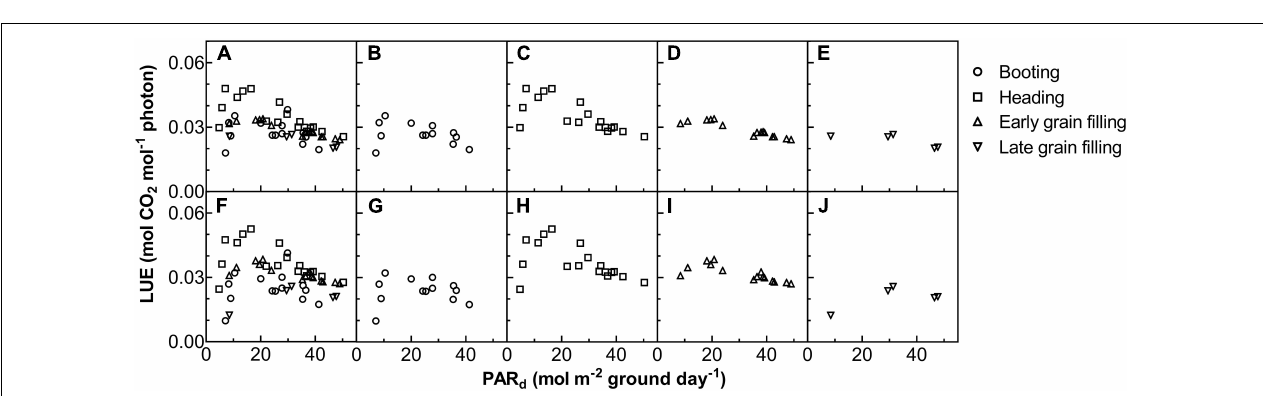
FIGURE 6 | The relationship between LUE on daily total photosynthetically active radiation (PAR d ) for ZY1 (A–E) and YM2 (F–J) . The shape of data points denotes the different growth stages. The data of all the four stages were shown together (A,F) and shown separately for booting (B,G) , heading (C,H) , early grain filling (D,I) , and late grain filling (E,J)